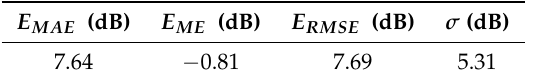
Table 4. Overall results of office environment 2.